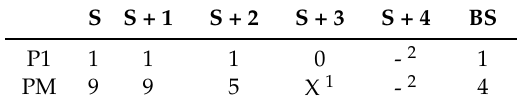
Table 1. Flags Bit Array—Pass I.